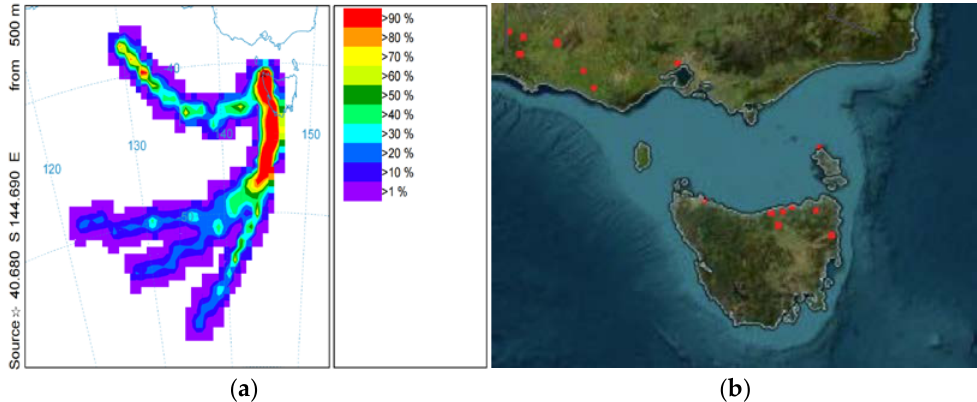
Figure 7. ( a ) 48 h backward trajectory frequency (500 m) arriving at Cape Grim site on 3 June 2019. The back trajectories were calculated using NOAA HYSPLIT 4.8 model. ( b ) The fire spots are from level 2 Terra/MODIS thermal anomalies/fire product (MOD14).